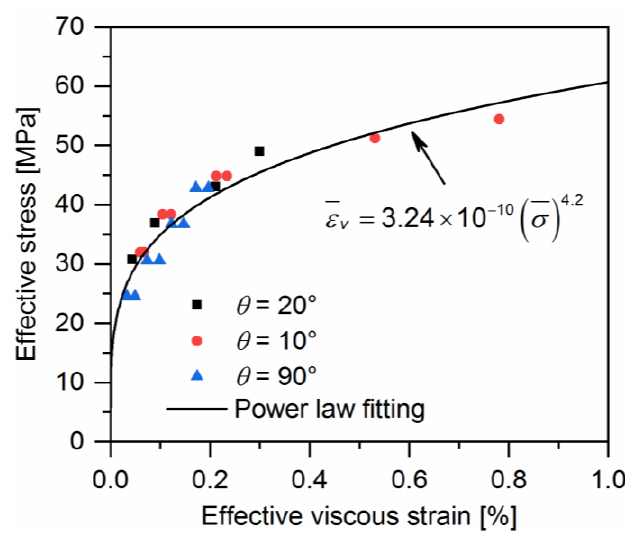
Figure 10. The effective stress-effective viscous strain relationship of quasi-UD E-glass/polypropylene composites.